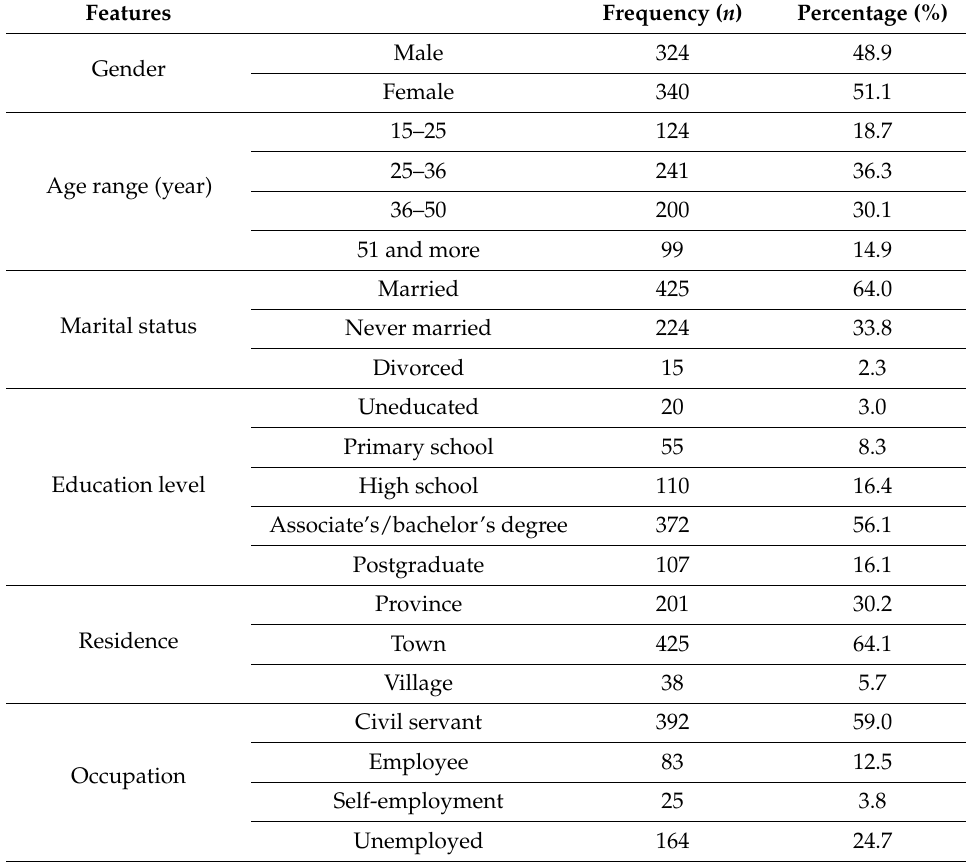
Table 1. Demographic features of the participants ( n =